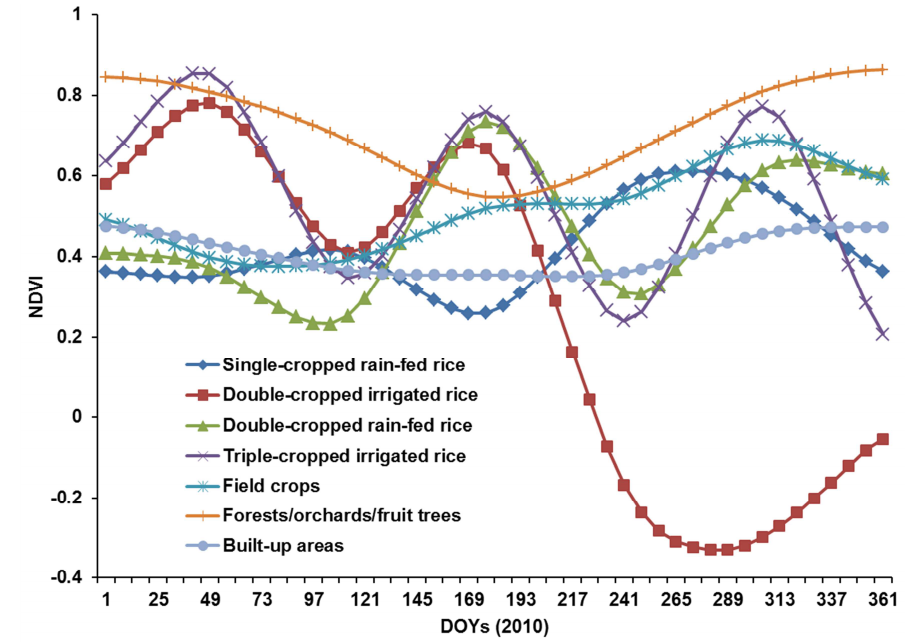
Figure 2. Mean NDVI profiles of land-use